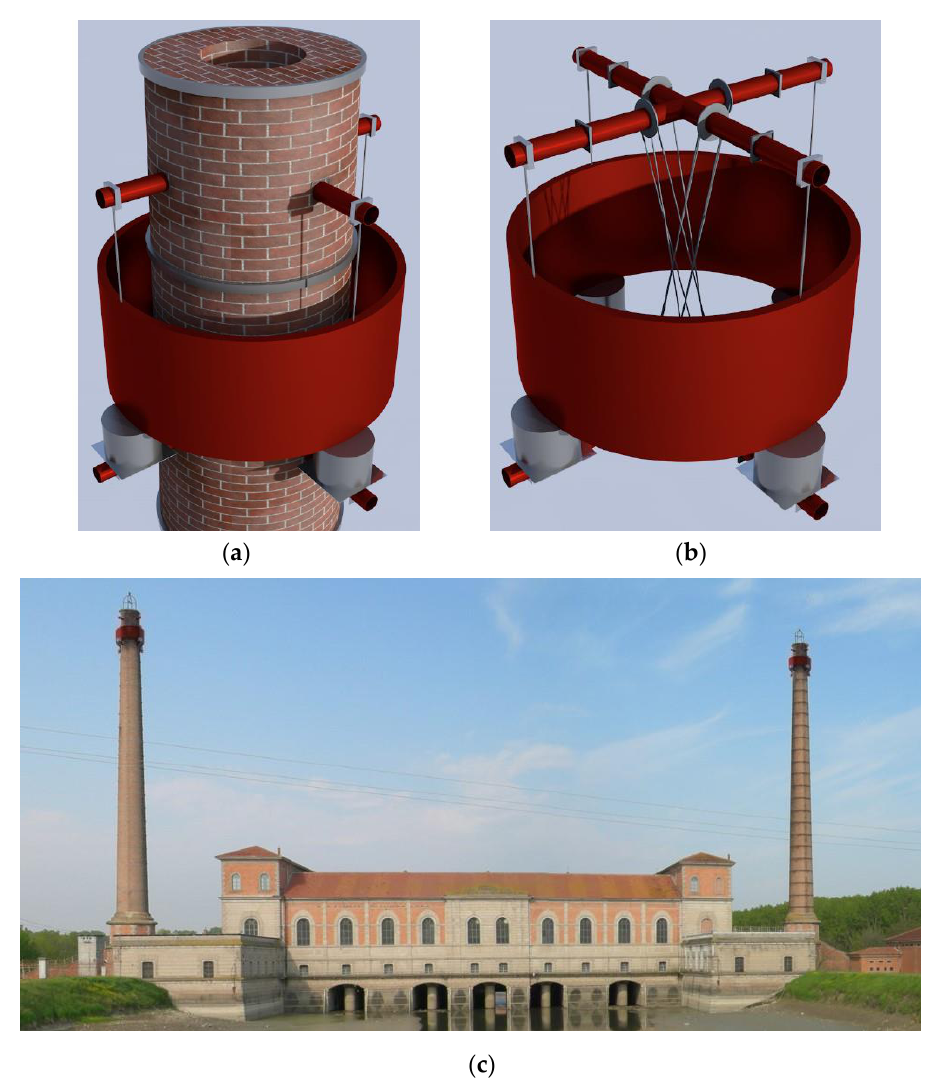
Figure 3. A 3D render of the real, tuned mass damper (TMD) design for a masonry slender structure proposed to the Italian Cultural Heritage. ( a ) The proposed first configuration with the TMD located near the top of the chimney, ( b ) steel TMD in detail, and ( c ) view of the historical hydraulic plant (Italy).